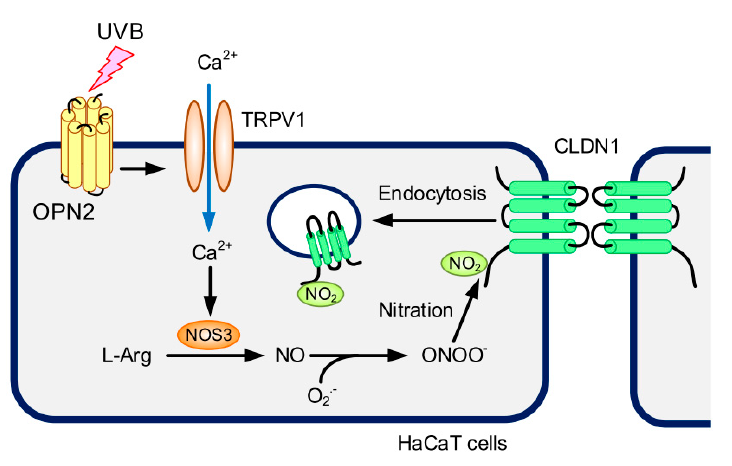
Figure 10. A proposal scheme for UVB responses in HaCaT cells.